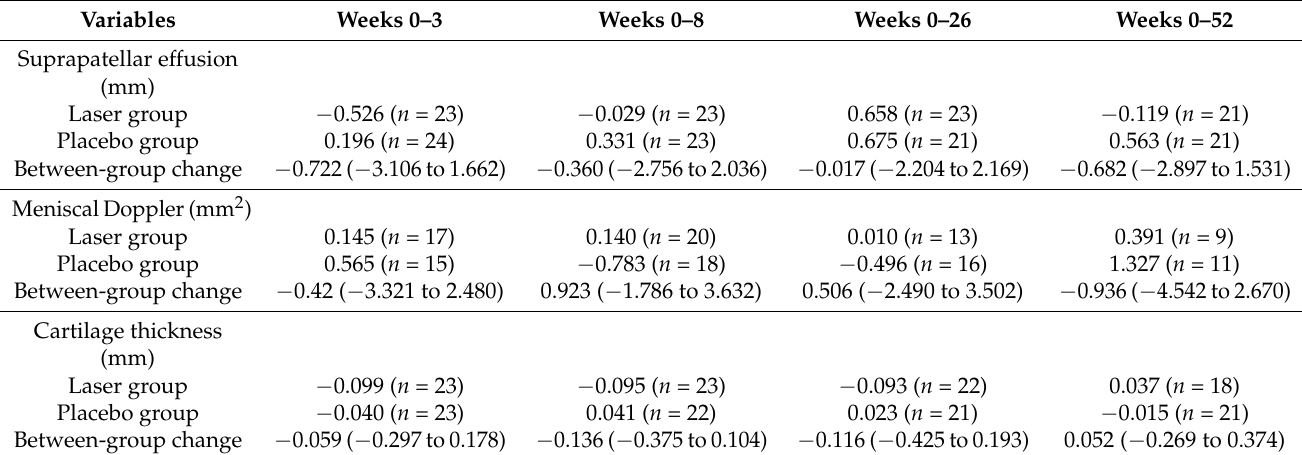
Table 4. RTU assessments: within- and between-group changes from baseline (higher score is